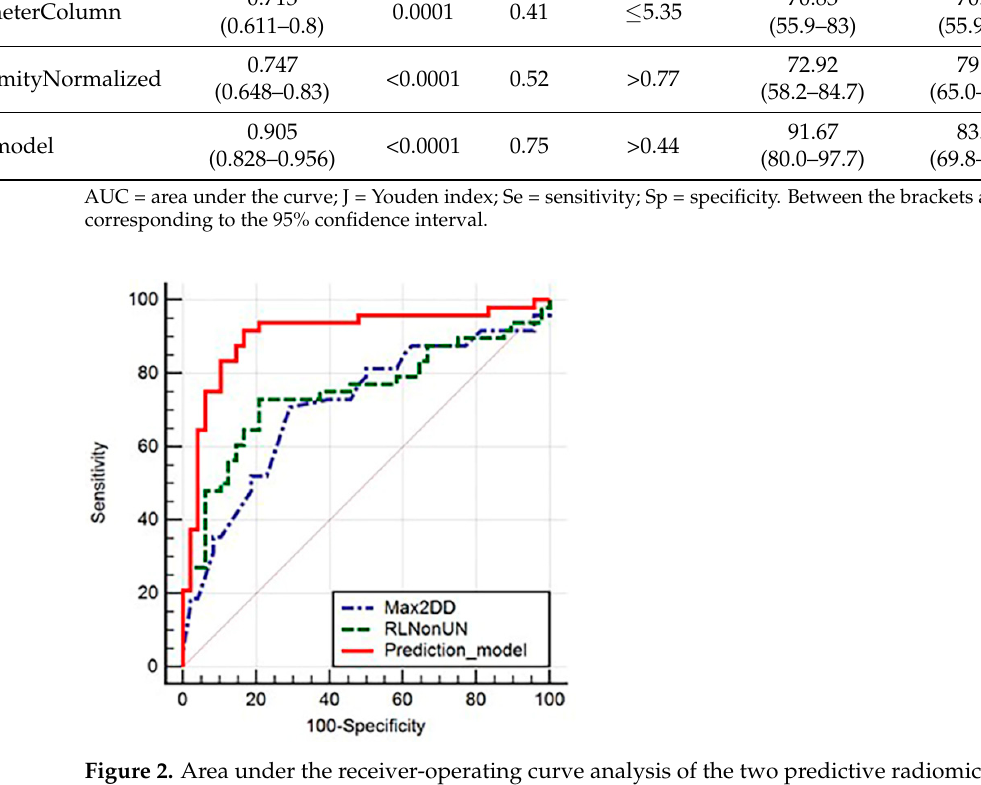
Figure 2. Area under the receiver-operating curve analysis of the two predictive radiomic features (Max2DDC and RLNonUN) and the prediction model for pSS parenchymal changes in LG. In our group of pSS subjects, no statistically significant correlation was found between the ESSDAI score and the Schirmer’s test values (Table 5). Table 5. Correlation between the two predictive radiomic features for pSS parenchymal changes in LG and the ESSDAI score and Schirmer test